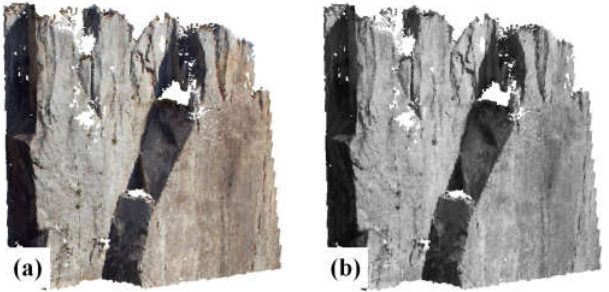
Figure 4. Point cloud model. ( a ) Original color of the point cloud model; ( b ) grayscale model.